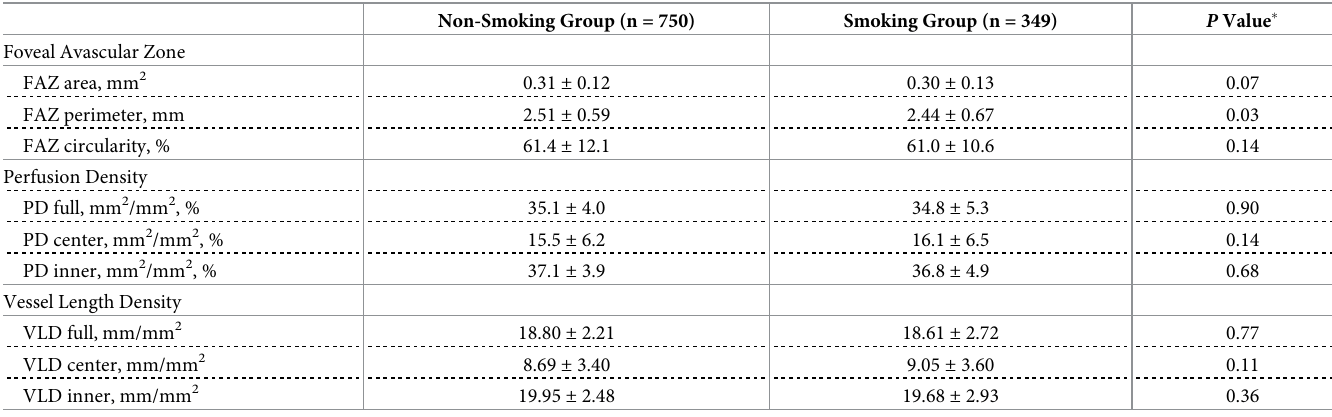
Table 2. OCTA parameter results stratified by smoking history.